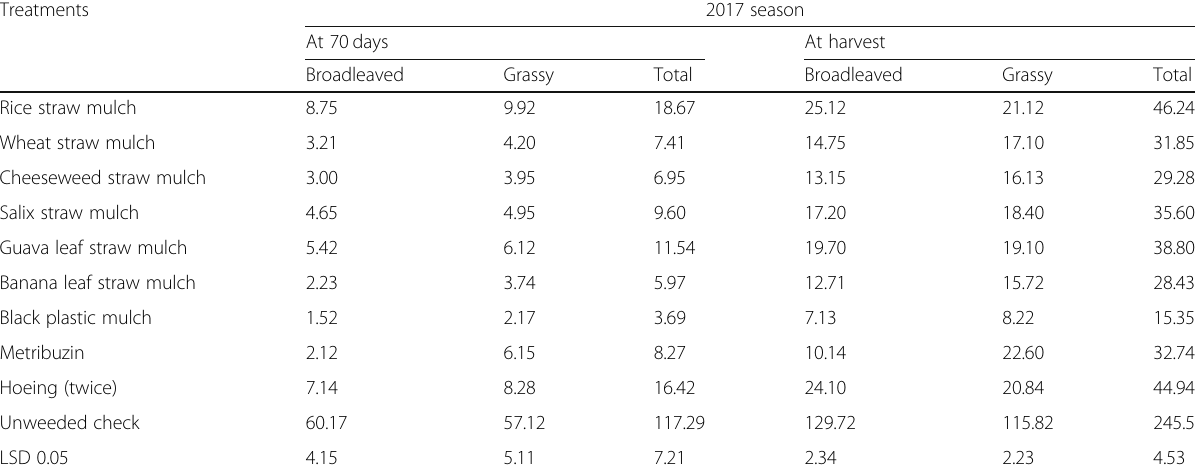
Table 1 Effect of different weed control treatments on dry weight of associated potato weeds (g/m 2 ) after 70 days from planting and at harvest during 2017 season Treatments